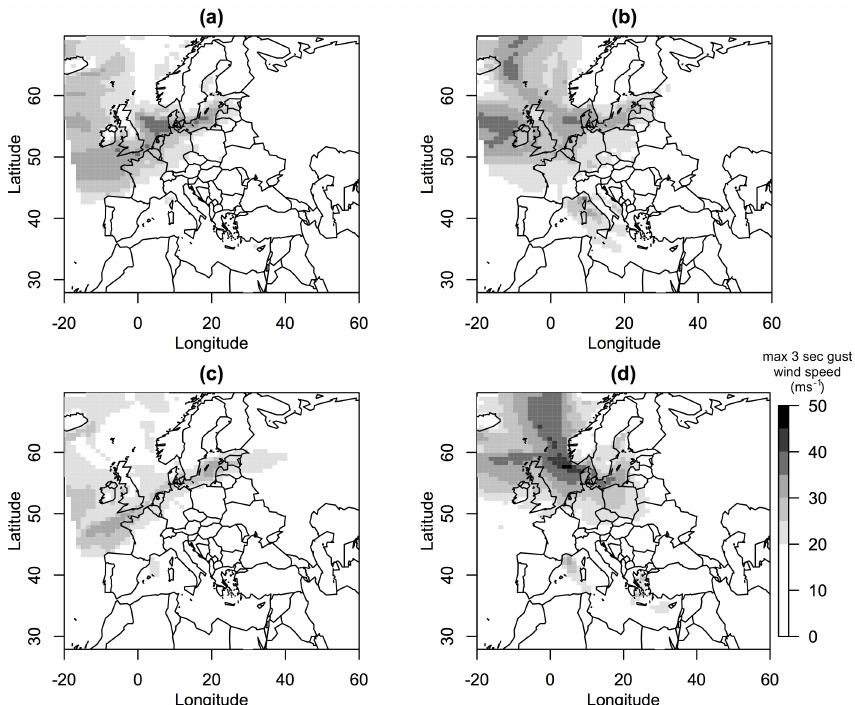
Figure 1. Windstorm footprints for (a) Daria (24–26 January 1990), (b) Vivian (25–27 February 1990), (c) Christian (27–29 October 2013) and (d) Xaver (4–6 December 2013). The footprint is defined as the maximum 3s wind gust speed (in ms − 1 ) over a 72h period centred around the time at which the maximum 925hPa wind speed occurs over land, estimated by dynamically downscaling ERA-Interim reanalysis to a 25km horizontal resolution using the Met Office unified model (see Sect.